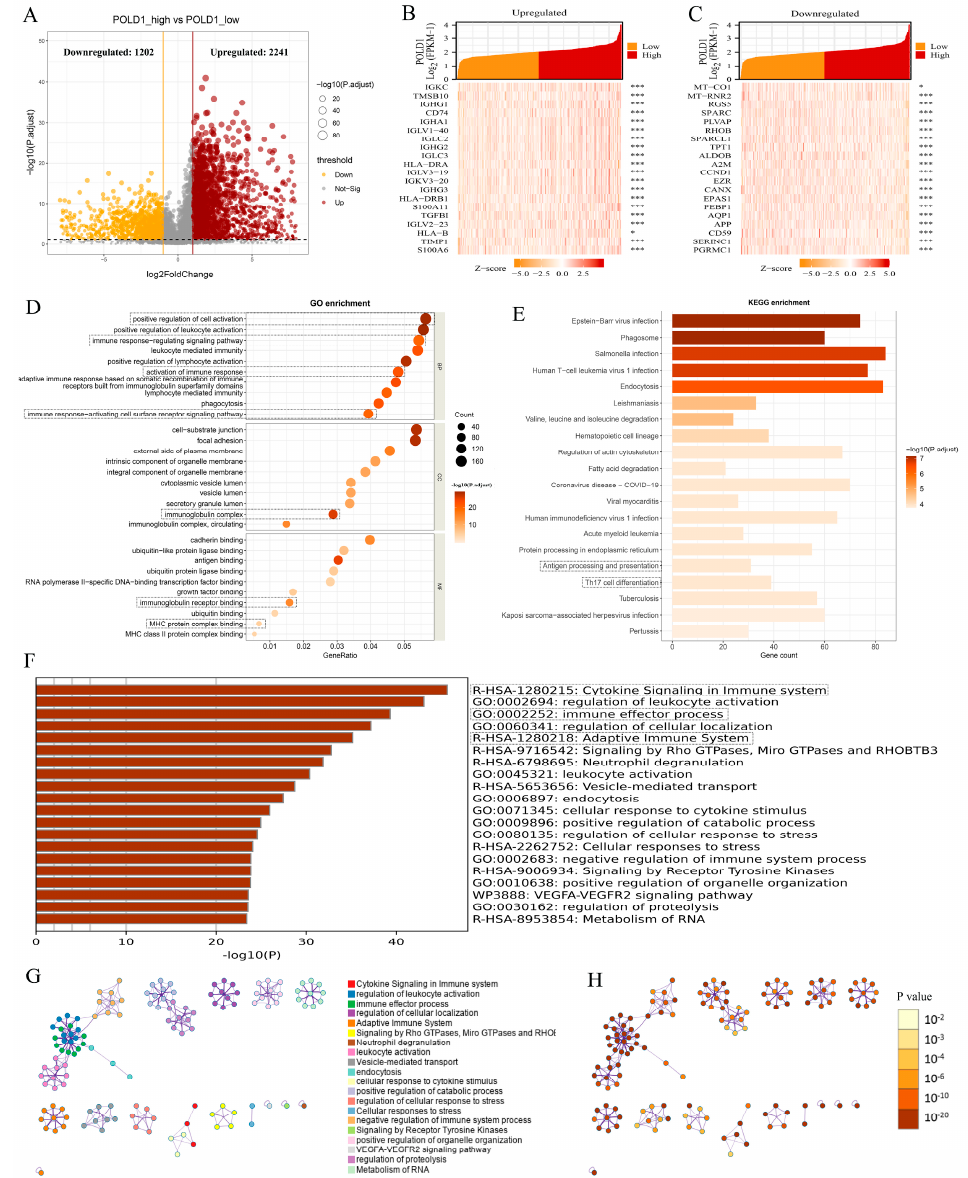
Figure 4. Functional enrichment analysis of the differentially expressed genes (DEGs) based on the POLD1 expression levels in ccRCC. ( A ) The volcano plot described 3443 DEGs (2241 upregulated and 1202 downregulated genes). ( B , C ) The heat maps depicted the expression of 20 significant upregulated ( B ) and downregulated ( C ) genes in the ccRCC samples with POLD1 high and POLD1 low expression. ( D , E ) GO ( D ) and KEGG pathway ( E ) enrichment results of DEGs in ccRCC samples with POLD1 high and POLD1 low expression. ( F – H ) The functional enrichment of POLD1-associated DEGs also analyzed via Metascape was shown in ( F ) the bar graph of the top 20 enriched terms, colored by p -value. ( G ) colored by cluster ID, where nodes with the same cluster ID are usually close to each other; ( H ) colored by p -value, where the terms containing more genes tend to have greater significance. * p < 0.05, *** p <